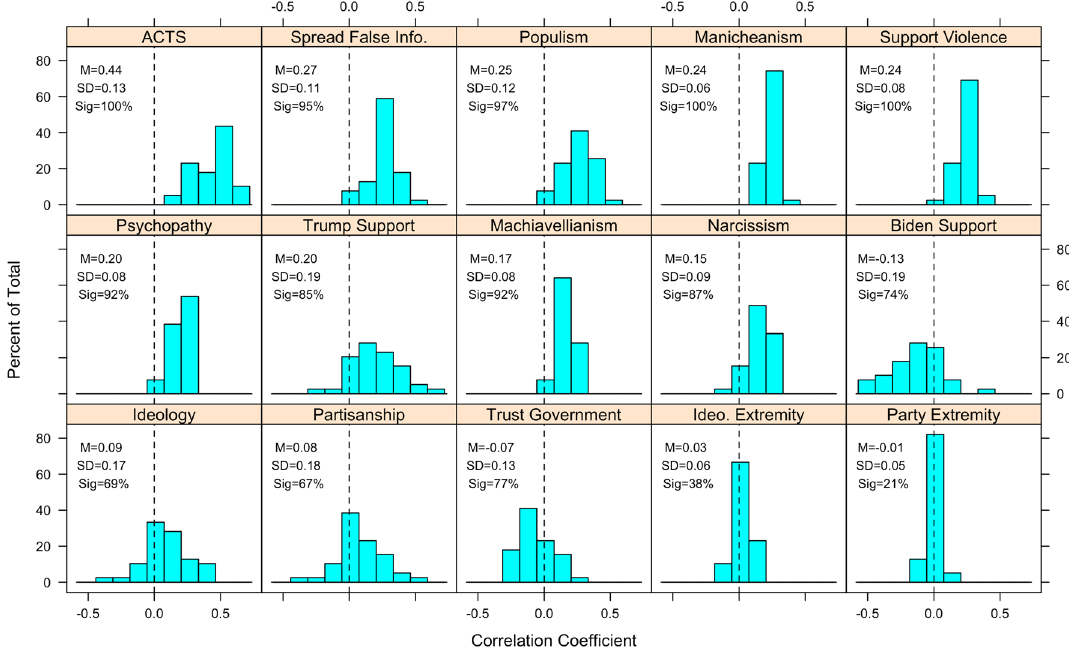
Figure 1. Distribution of correlation coefficients, by psychological and political correlates, across all conspiracy theory beliefs. Mean, standard deviation, and percentage of cases where correlation was statistically significant ( p < 0.05) appears in text. p -values corrected for multiple comparisons via the Benjamini–Hochberg